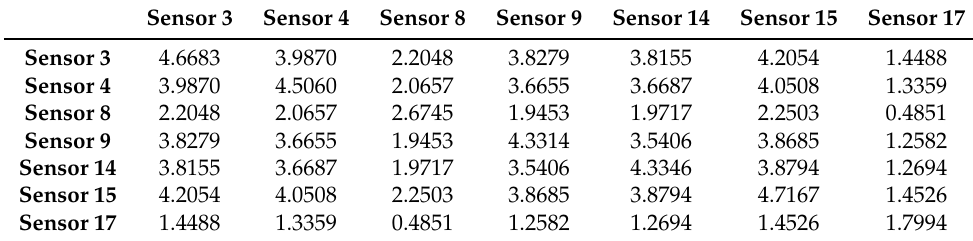
Table 6. Mutual information values among sensors selected by quantitative strategy for data set 2.